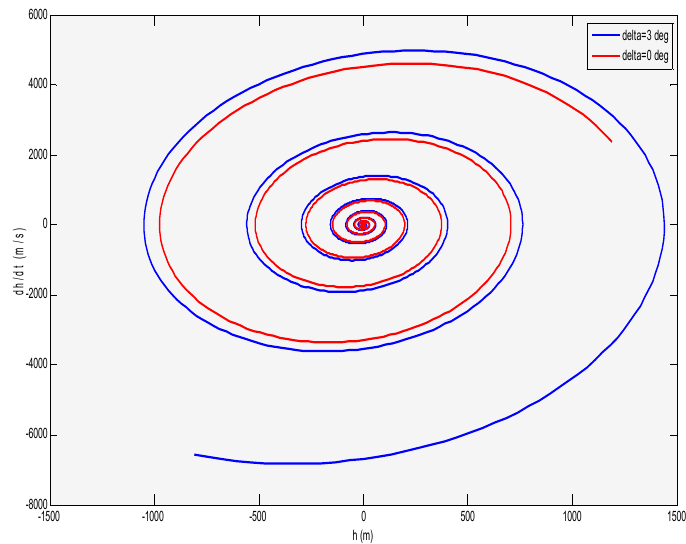
Figure 30. The state space response of alpha without freeplay and with 2 ◦ freeplay. (In upper speed of flutter).